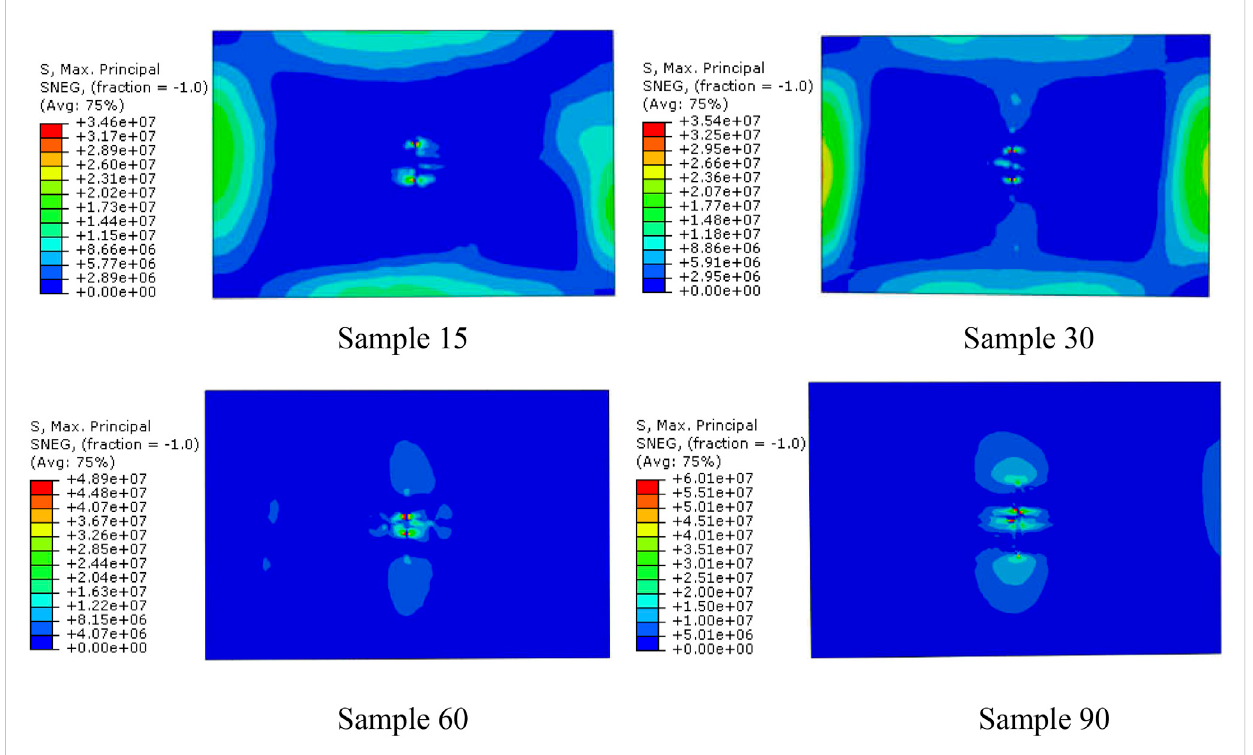
FIGURE 4 Nephogram of the maximum principal stress distribution of four biomimetic composite models when the impact energy is 20